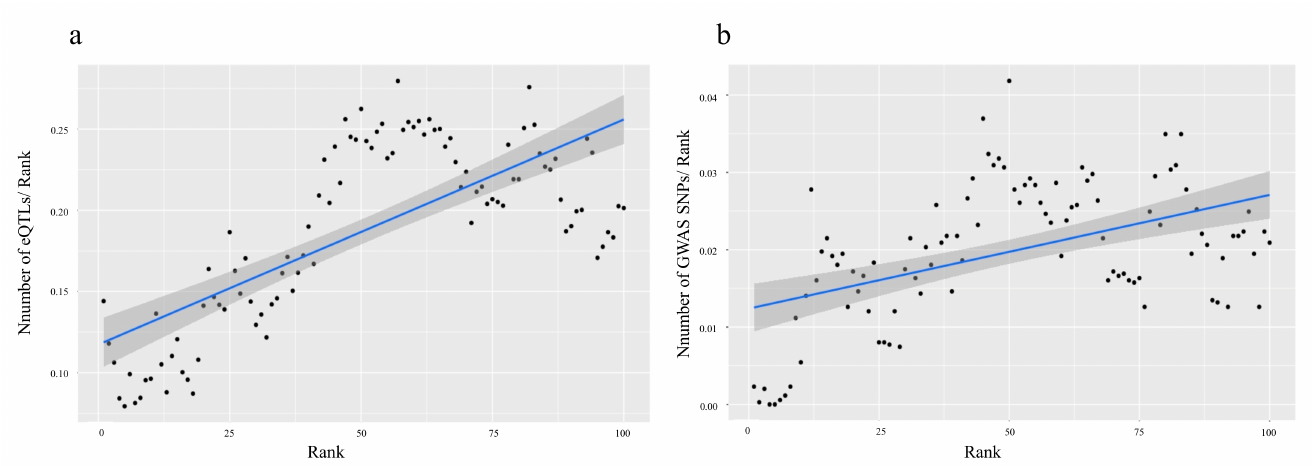
Figure 3. Q-Q plots showing a significant positive correlation of the number of ( a ) eQTLs and ( b ) GWAS SNPs in the resulting rSNP set with predicted probabilities. All rSNPs were divided into 100 equal parts or ranks (the abscissa); the ordinate shows the number of ( a ) GTExeQTLs or ( b ) GWAS associations mapped to all SNPs of a particular